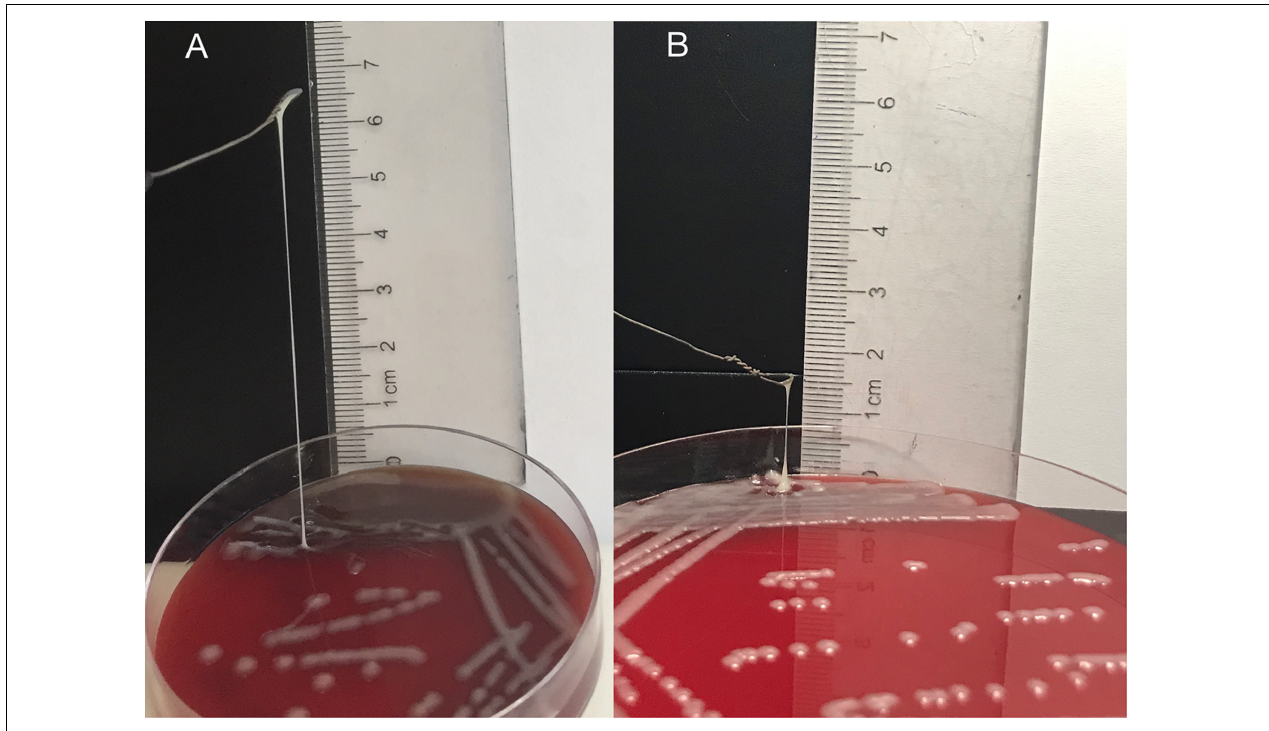
FIGURE 2 | String test of NY03 (A) and NY03r